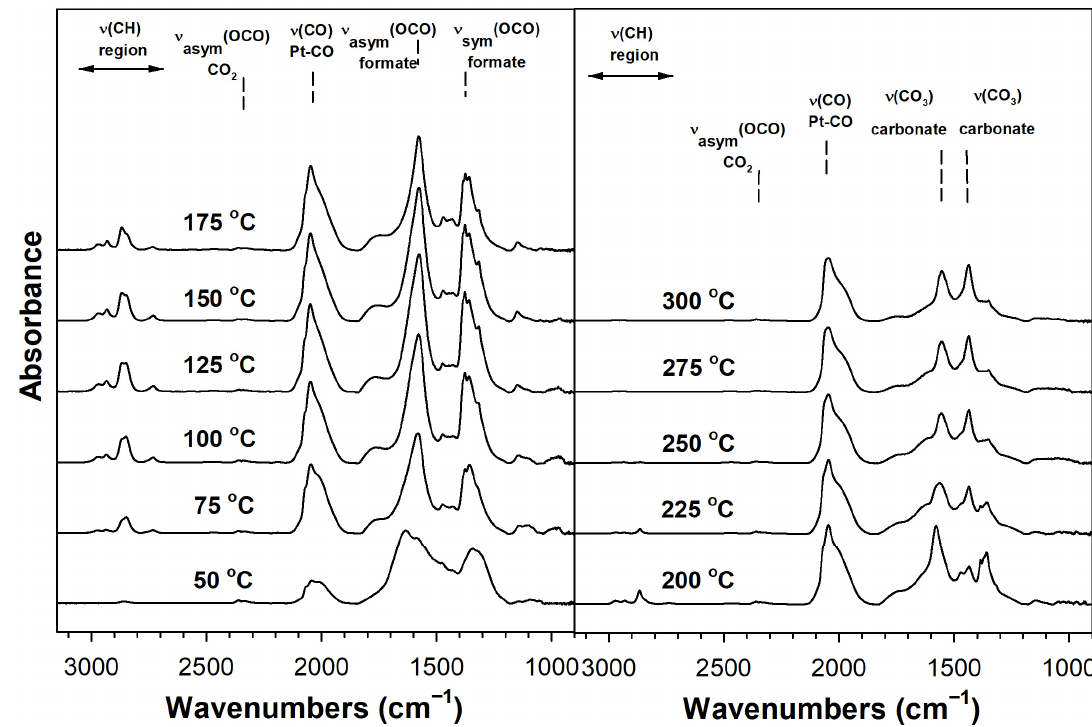
Figure 2. DRIFTS of steam reforming of formaldehyde over 2%Pt/m-ZrO 2 .